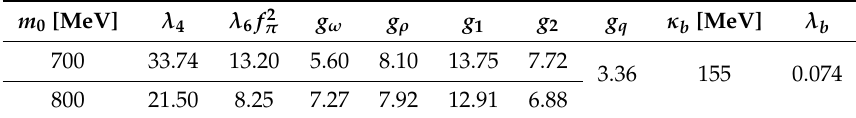
Table 3. Sets of the model parameters used in this work. The values of λ 4 , λ 6 and g ω are fixed by the nuclear ground state properties, and g ρ by the symmetry energy (see the text). The remaining parameters, g q , κ b , and λ b , do not depend on the choice of m 0 , and their values are taken from Ref. [16]. m 0 [MeV] λ 4 λ 6 f 2 π g ω g ρ g 1 g 2 g q κ b [MeV] λ b 700 33.74 13.20 5.60 8.10 13.75 7.72 3.36 155 0.074 800 21.50 8.25 7.27 7.92 12.91